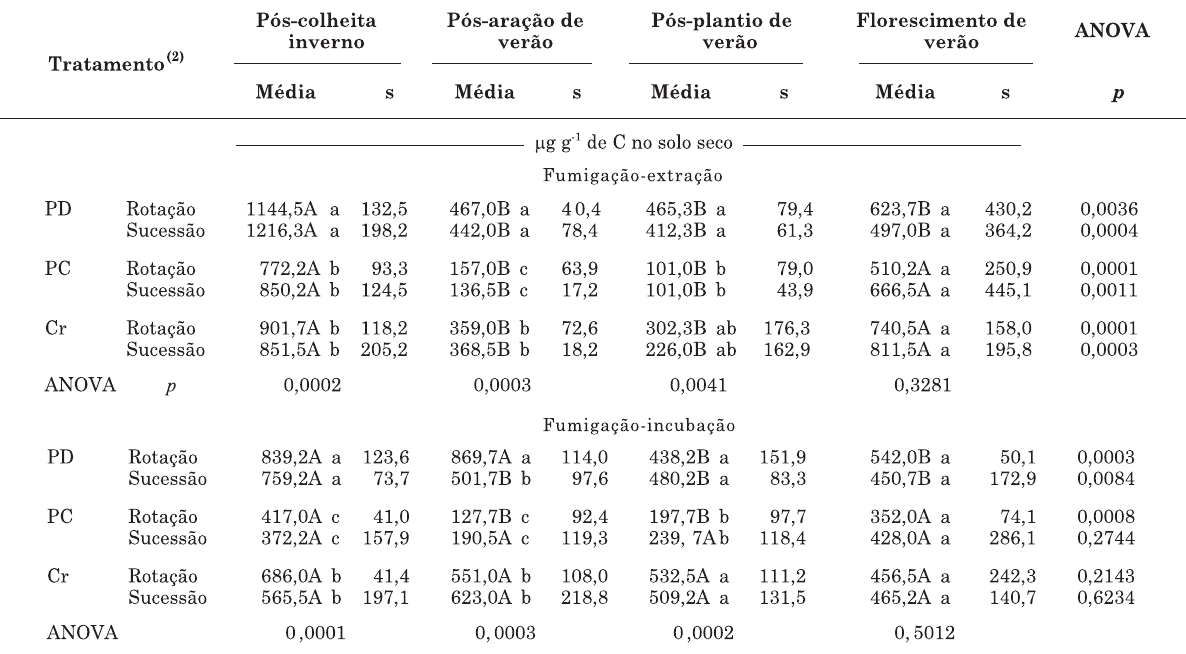
observadas em apenas três dos seis tratamentos (Quadro 1). Isso pode indicar maior sensibilidade do FE para detecção de